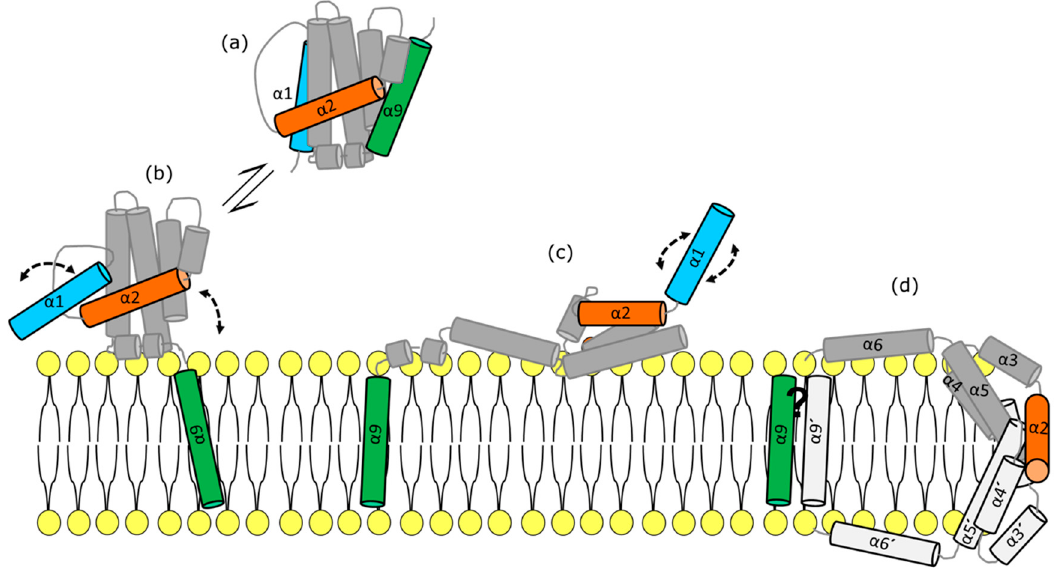
Figure 2. BAX/BAK structural organization during their activation process. ( a ) Protein disposition in solution. BAX is represented with nine cylinders corresponding to its nine α -helixes and based on [41]. ( b ) BAX/BAK early activation steps: including TM dislodgement and N terminal exposure (depicted in green and cyan respectively). ( c ) BAX/BAK reorganization in two different parts (dimerization and piercing domains) and BH3 domain exposure (depicted in orange). ( d ) Oligomerization and pore formation, structural representation of membrane embedded BAX/BAK in the context of toroidal pore (clamp model, based on [70]). One monomer is showed in grey ( α 1–9) and the other is depicted in dark grey ( α 1 (cid:48) –9 (cid:48) ). The relative orientation of the helices 9 remains